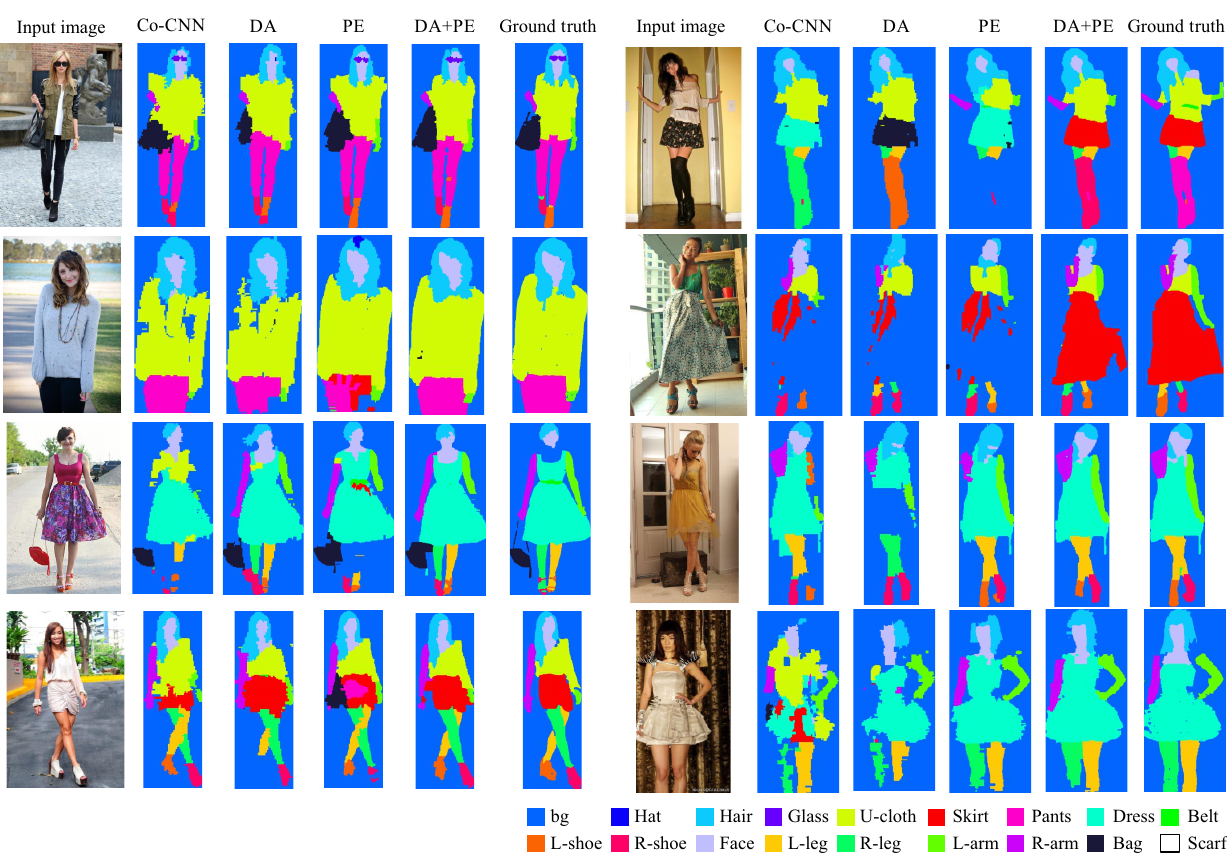
Fig. 4 Segmentations produced by each method.